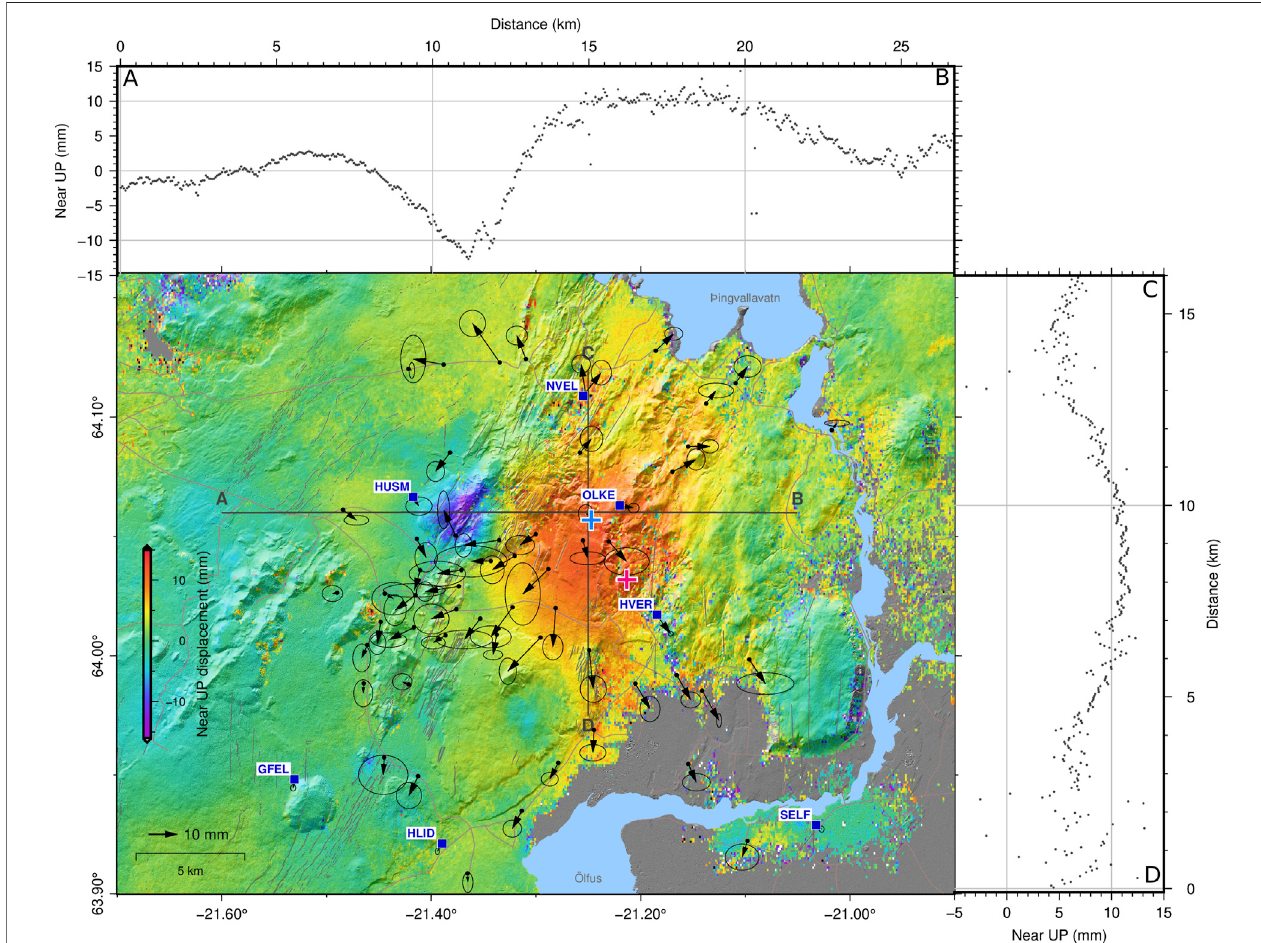
FIGURE 4 | Near-up component from the differentiation of our 2017 – 2018 and 2015 – 2017 Sentinel-1 velocity fi elds, assuming no subsidence during the ∼ 5 months of deep-seated in fl ation (Section 2.2). Associated GNSS horizontal displacements (black arrows; 2017 – 2018 displacements corrected as explained in the text) from campaign and continuous data sets and their respective 95% con fi dence ellipse are indicated. InSAR time series analysis, mean velocities and separation of components following themethodology from Drouin and Sigmundsson (2019). Pro fi les (A – B and C – D) acrossthe InSAR near-up displacements are shown in side plots. This fi gure highlights an uplift in Ölkelduháls (eastern part of Hengill) and subsidence over the main injection fi elds of the Hellisheiði geothermal plant thereafter referred as Húsmúli. Please refer to the caption of Figure 1 for meaning of the pink and blue crosses.